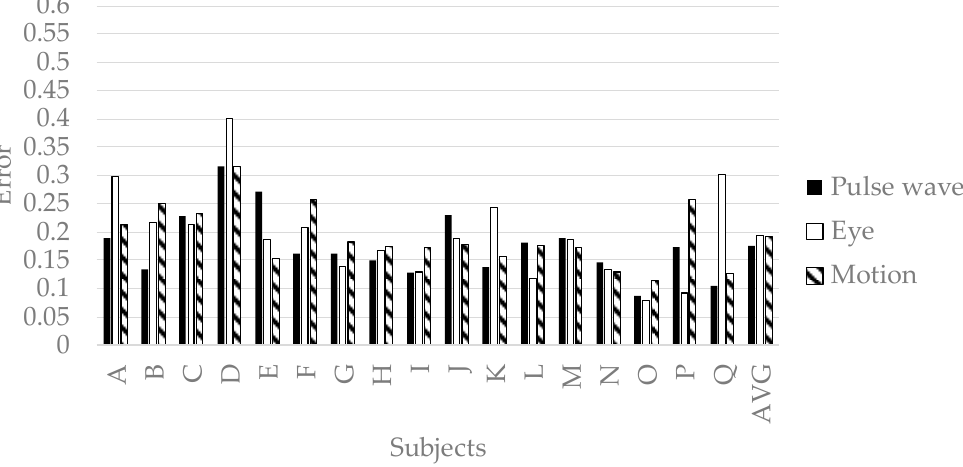
Figure 7. The accuracy of generalized model of pleasant emotion.